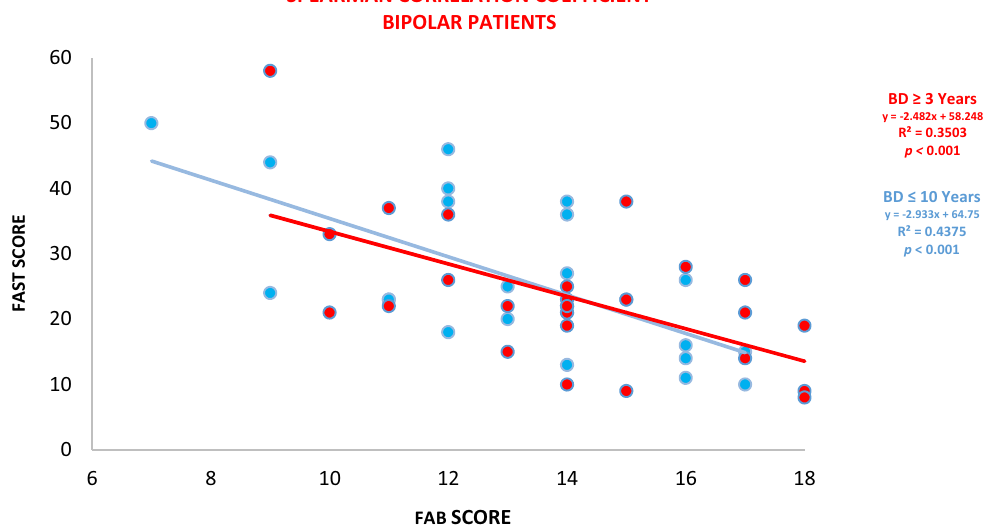
Figure 1. Correlation between FAST and FAB tests scores between BD patients ≤ 3 years (in red) and ≥ 10 years of the disease (in blue) using the Spearman Correlation Coefficient. This image was obtained with permission (IJAERS). Image origin: Cyrino et al., (2021). Assessment of different domain impairments in Cognitive Functions and Functionalities found in Euthymic Patients with Bipolar Disorder I / II—during the early and late phases of the disease, using the FAB and FAST tests. International Journal of Advanced Engineering Research and Science (IJAERS). 8, 401–433.